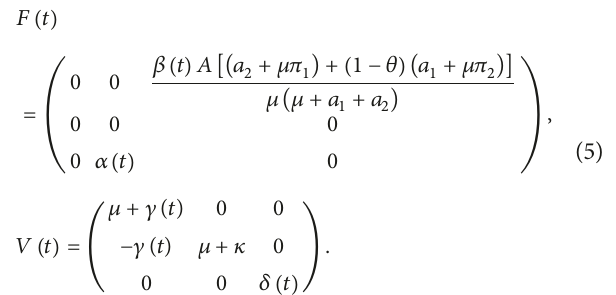
Figure 1: Diagram of the model